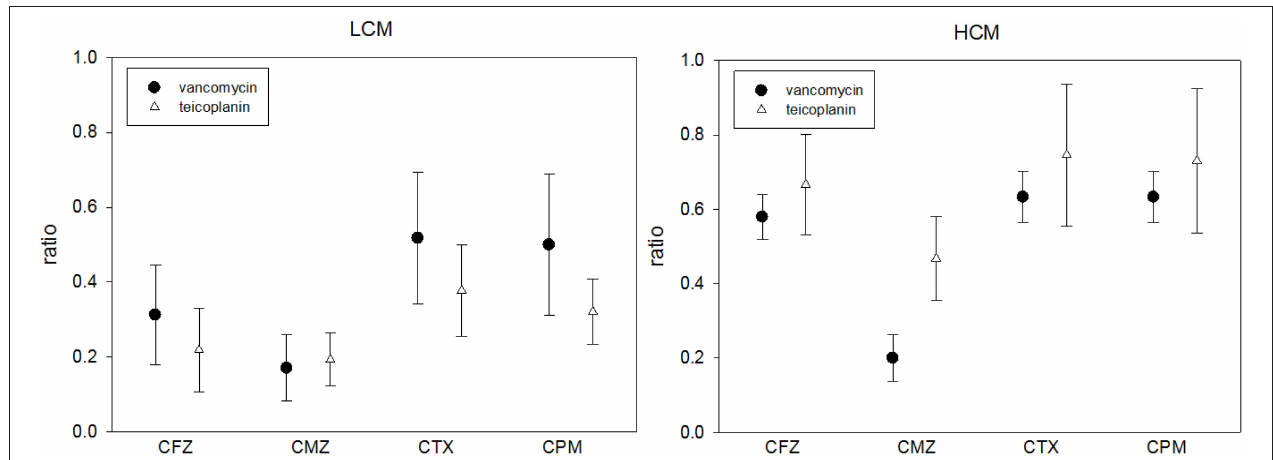
FIGURE 3 | The MIC ratios of vancomycin or teicoplanin in the presence and absence of 8 µ g/mL cephalosporin in 21 low-cefazolin MIC (LCM) and 13 high-cefazolin (HCM) isolates. (MIC ratio = glycopeptide MIC in the presence of 8 µ g/mL of a cephalosporin/glycopeptide MIC without cephalosporin; means ± standard